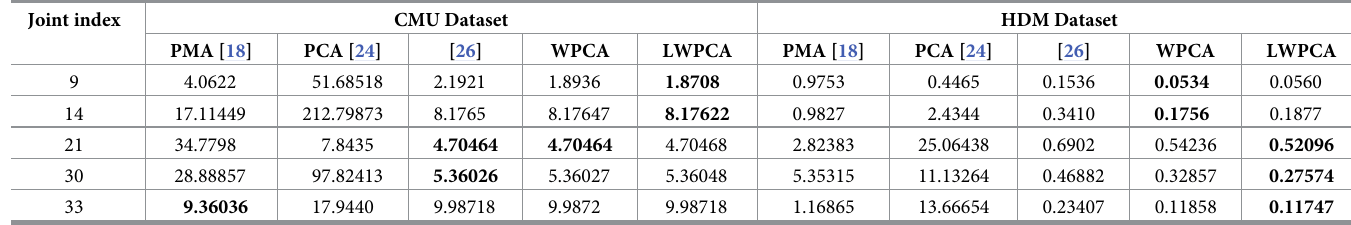
Table 1. Mean recovery error for missing a single marker (The small value indicates small error according to Eq 15. The results of all joints in the S1 Appendix). Joint